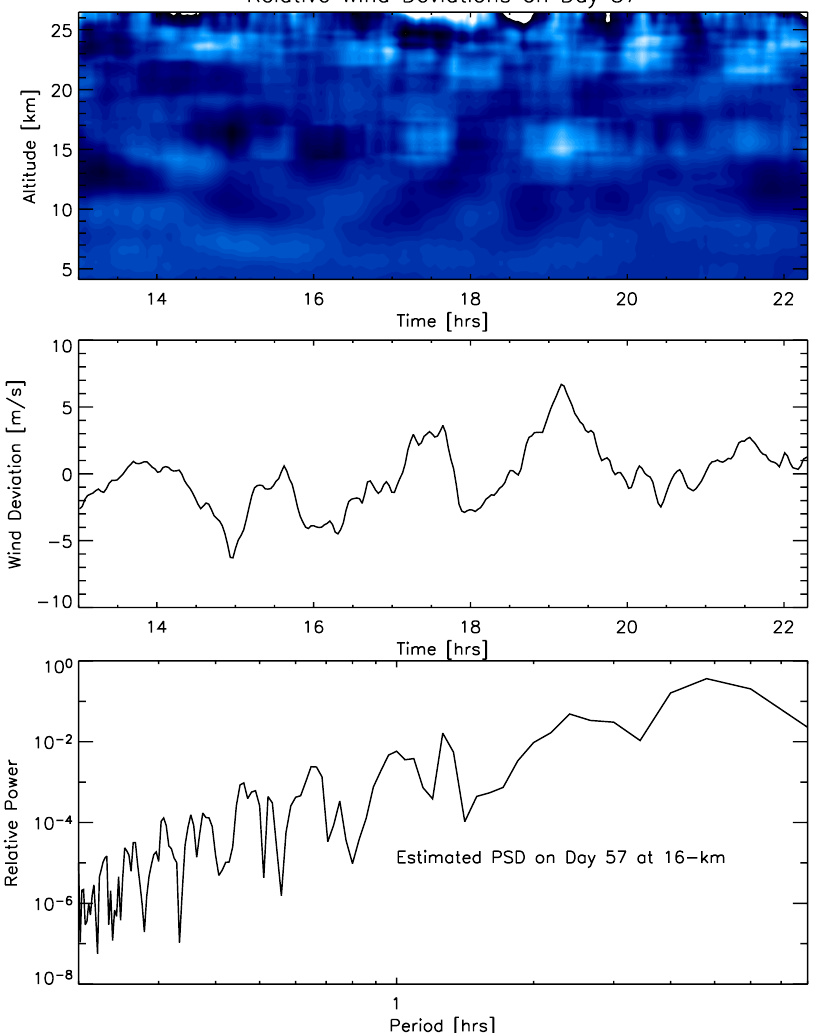
Fig. 3. More detailed view of the ducted feature from day 57. [top] Raw zonal wind deviations from the daily mean wind profile, ranging from -5-m/sec to 5-m/sec on the black-blue-white color table. No filtering has been utilized. [middle] Wind deviation profile at 16-km. [bottom] An estimate of the power spectral density [PSD] from the 16-km altitude.